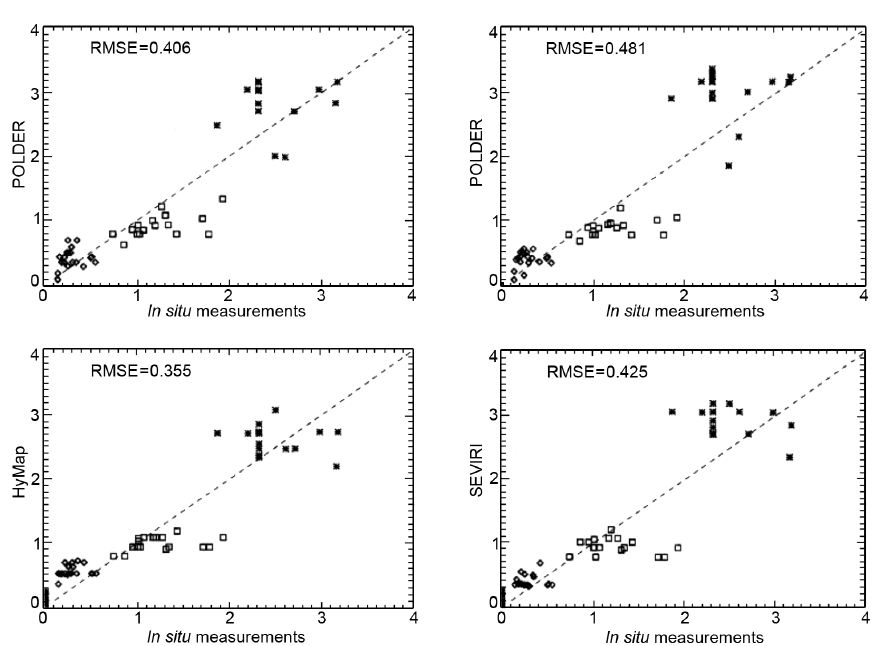
Fig. 6. Relationship between field-measured LAI and airborne-derived LAI using different data sets. The fig- ure at the top corresponds to POLDER data in the principal ( left ) and orthogonal ( right ) plane. Different sym- bols are used to represent corn ( ), sugar beet ( ) and alfalfa ( ∗ ). 4 Z